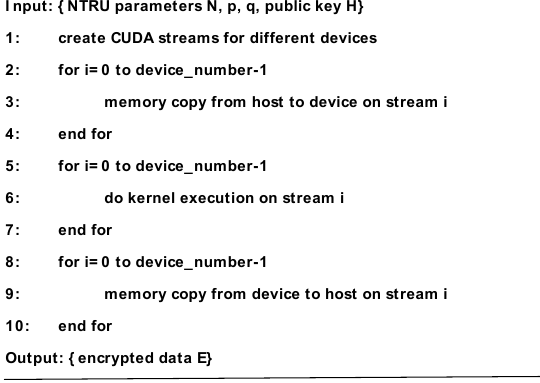
Fig. 6. multi-gpu implementation